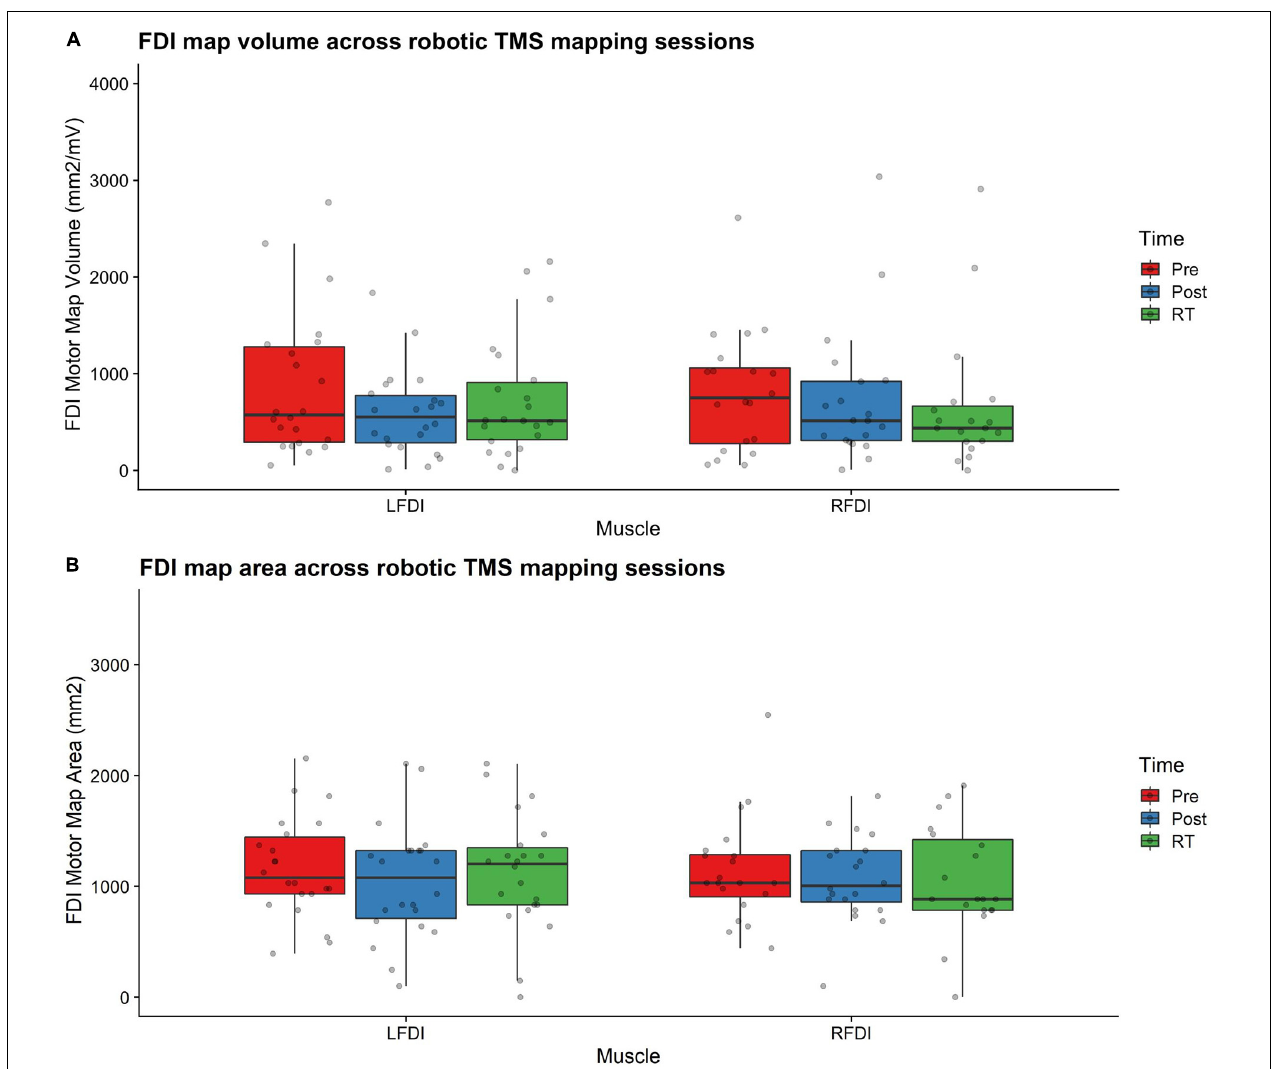
FIGURE 3 | FDI map volume and area. (A) FDI map volume (mm 2 /mV) and (B) area (mm 2 ) across robotic TMS motor mapping sessions. Map volume (mm 2 /mV) = Cumulative active map area × MEP amplitude (mV) at each responsive grid-point; Map area (mm 2 ) = Grid spacing (49mm 2 ) × number of responsive grid-points; LFDI = left-hand first dorsal interosseous muscle; RFDI = right-hand first dorsal interosseous muscle; Pre = baseline (red); Post = day 5 (blue); RT = six-weeks retention time (green). Box ends are interquartile range, the line is median, and the whiskers are 5–95%.